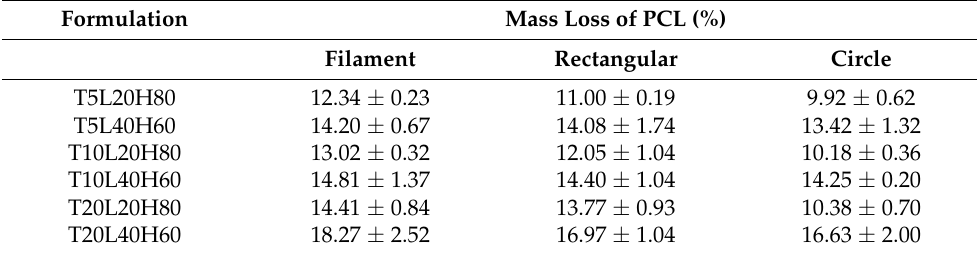
Table 4. Mass loss of PCL implants over 180-day release.